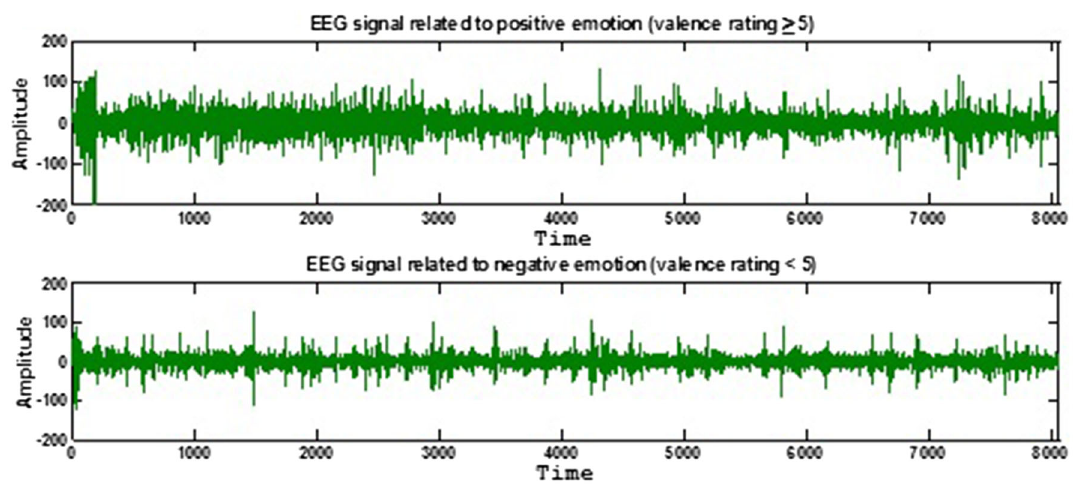
Fig. 4 Sample EEG signals related to positive and negative emotions. Sample EEG signals were measured from channel Fp1. Time axis was defined as second; amplitude axis was defined as l V